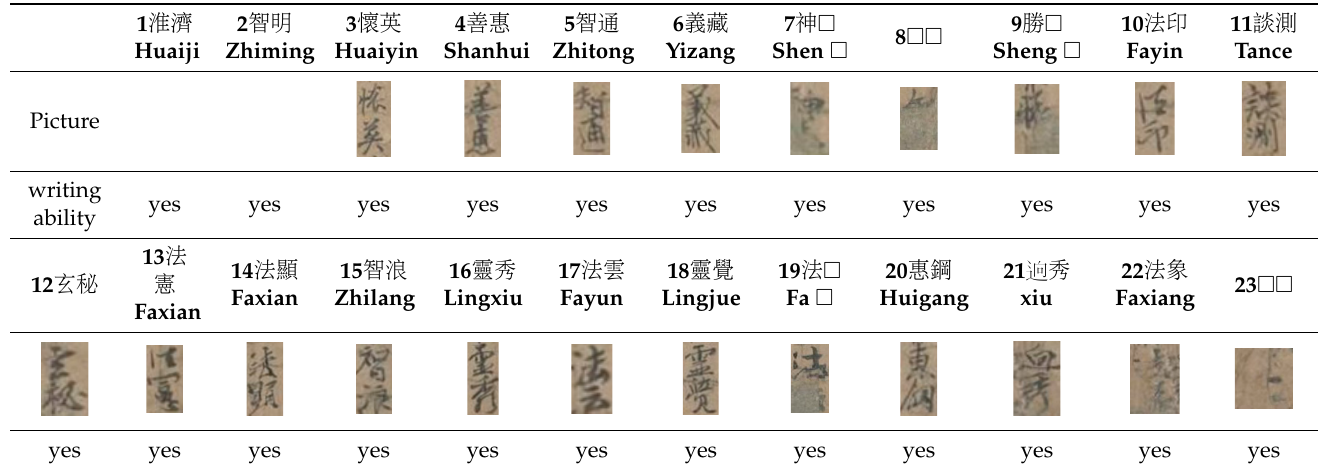
Table 1. Calligraphy of monks of Jinguangming Monastery in 841.